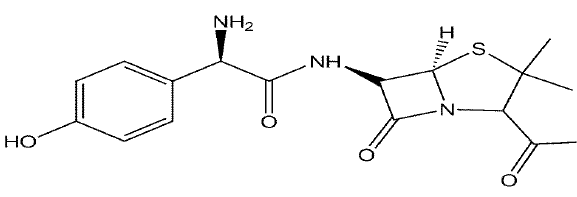
Figure 1. Chemical structure of amoxicillin.